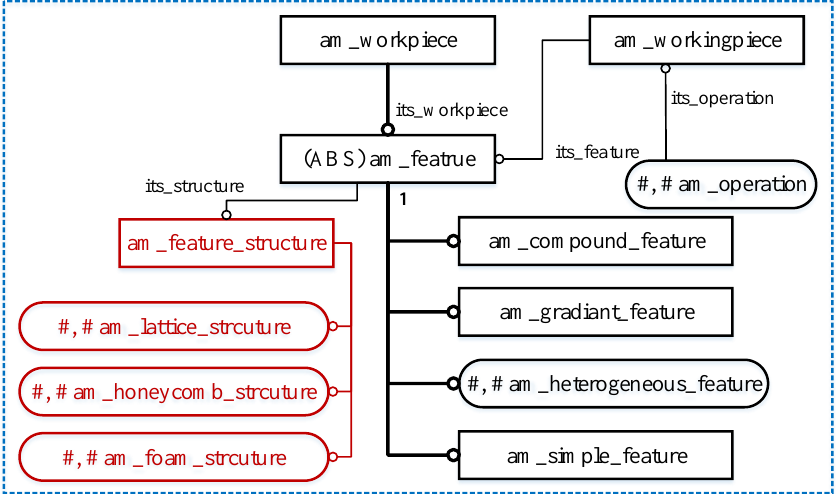
Figure 4. Extended STEP-compliant AM feature data model [15].